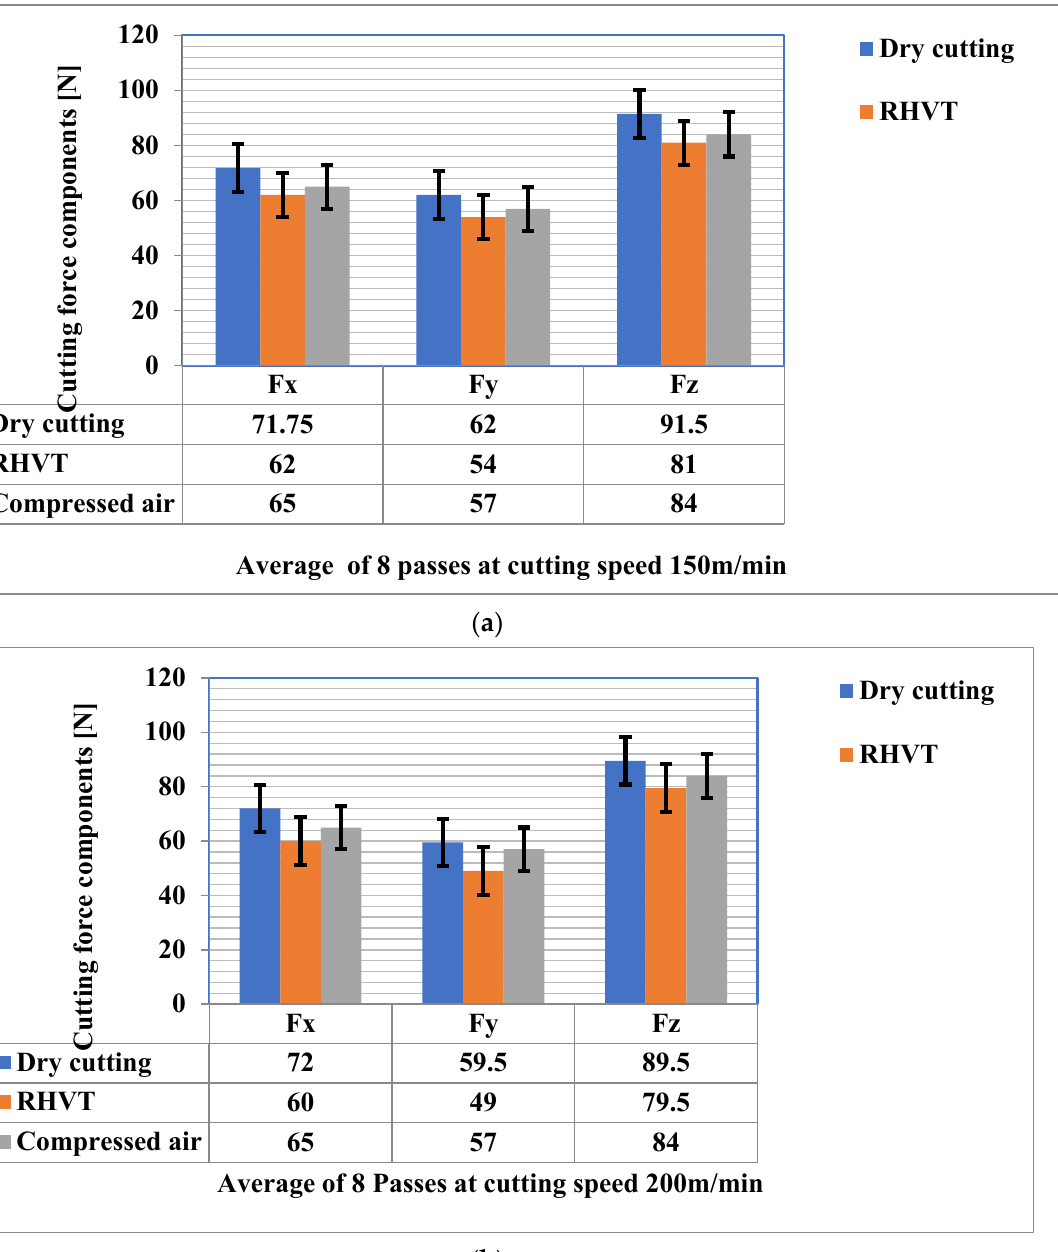
Figure 13. Cutting force components under different cooling strategies at cutting speed of ( a ) 150 m/min, and ( b ) 200